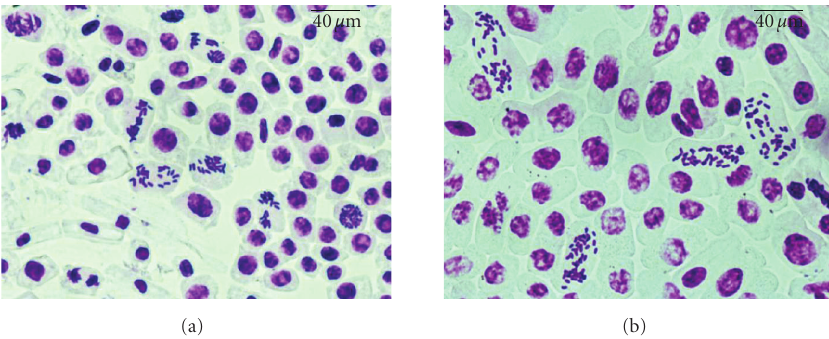
Figure 2: Chromosomes in root tip cells of (a), Diploid (2x = 22) and (b), Tetraploid (4x = 44) plantlets. Bar = 40 μ